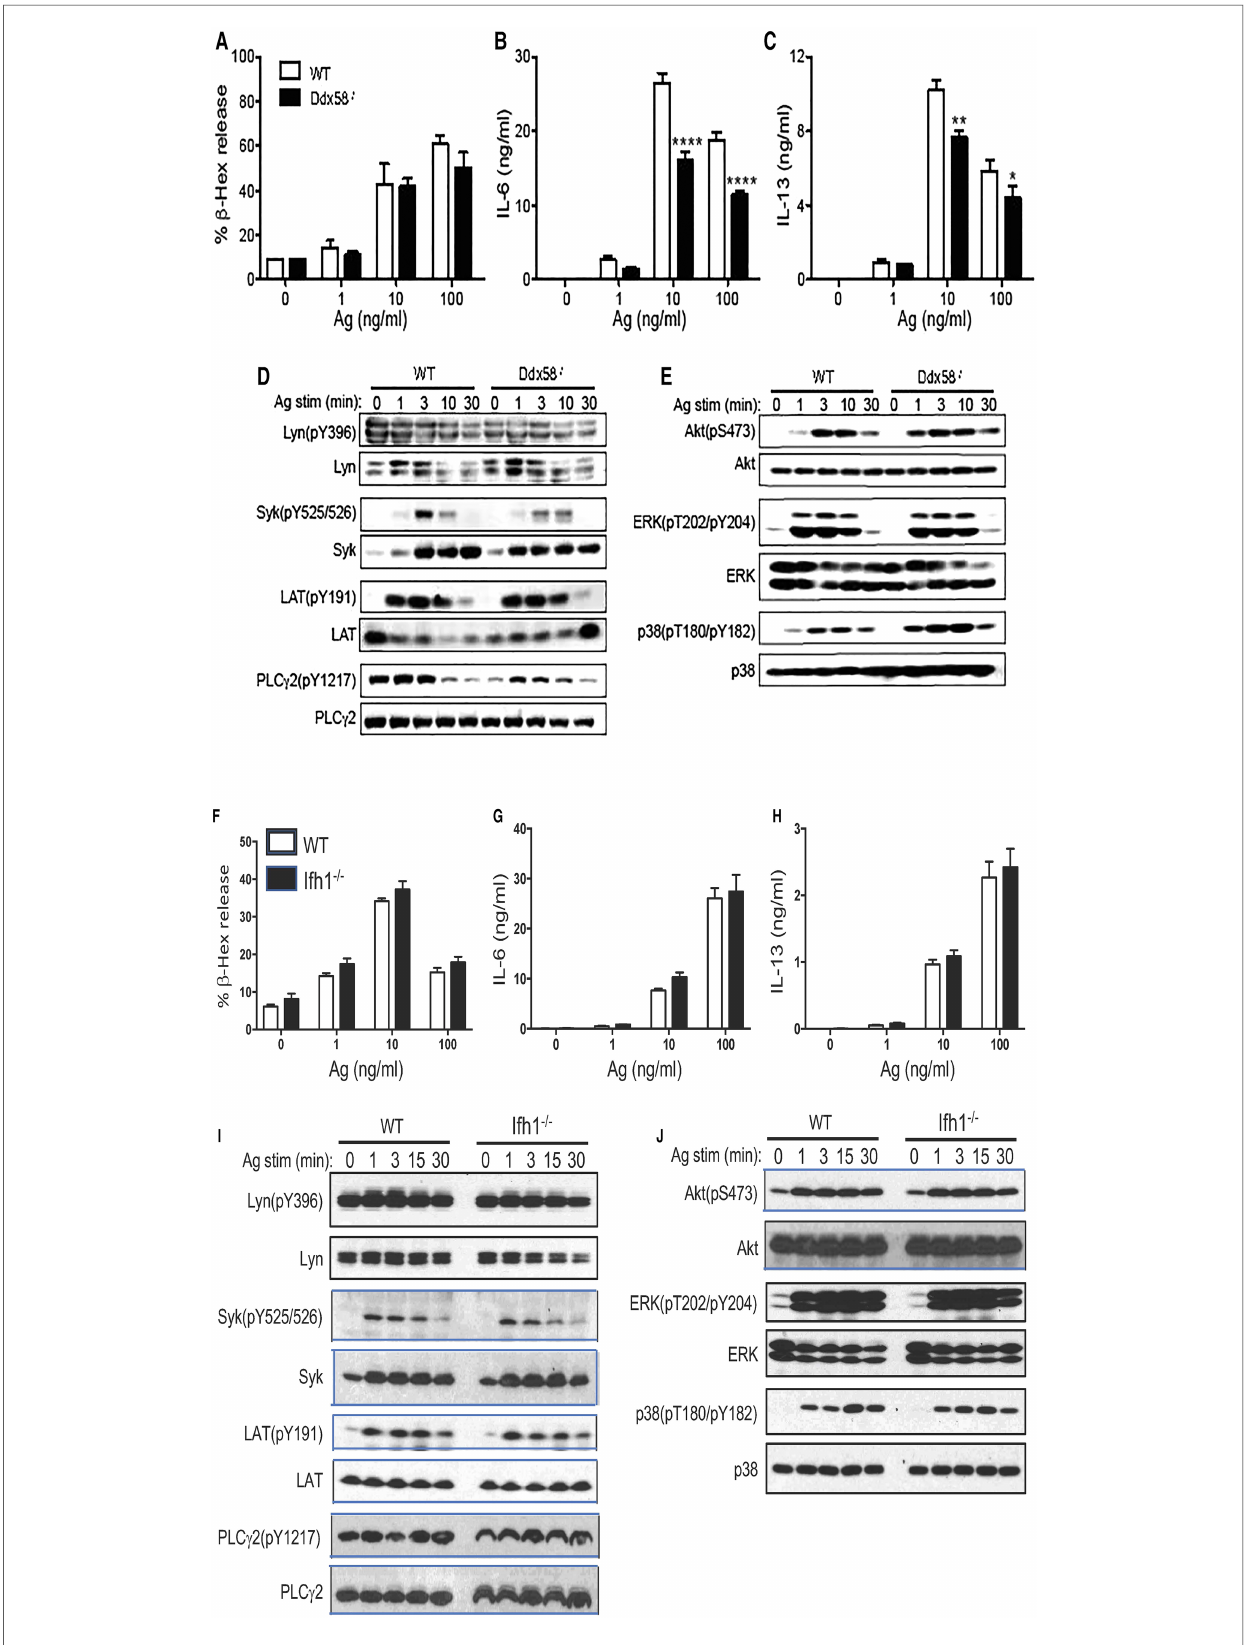
FIGURE 4 Fc ϵ RI-stimulated biologic and signaling outcomes in Ddx58 − / − , Ifh1 − / − and Irf3 − / − BMMCs. WT, Ddx58 − / − ( A-E ), Ifh1 − / − ( F-J ) and Irf3 − / − ( K-O ) BMMCs were sensitized with anti-DNP IgE and stimulated with the indicated concentrations of DNP 23 -HSA (Ag) for 45 min (for degranulation) or 20 h (for secretion of cytokines). Results representative of two independent experiments are shown. Signaling analysis was conducted once as described in Figure 2